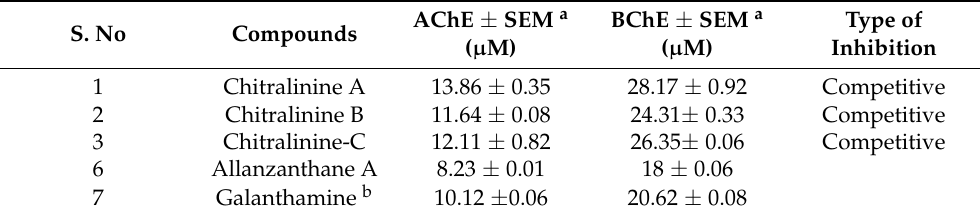
Table 4. AChE and BChE inhibitory activities of alkaloids from D. Chitralense .